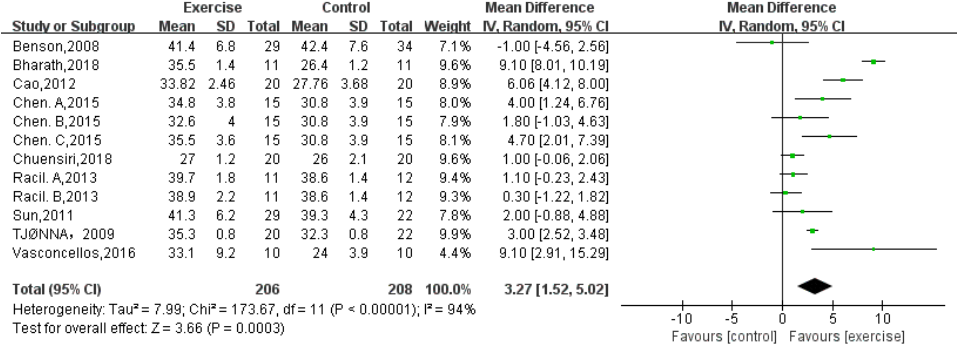
Figure 8. Forest plot of VO 2 peak.